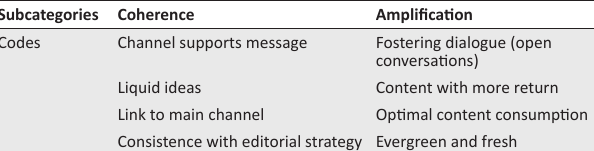
TABLE 4: Category 3: Understanding